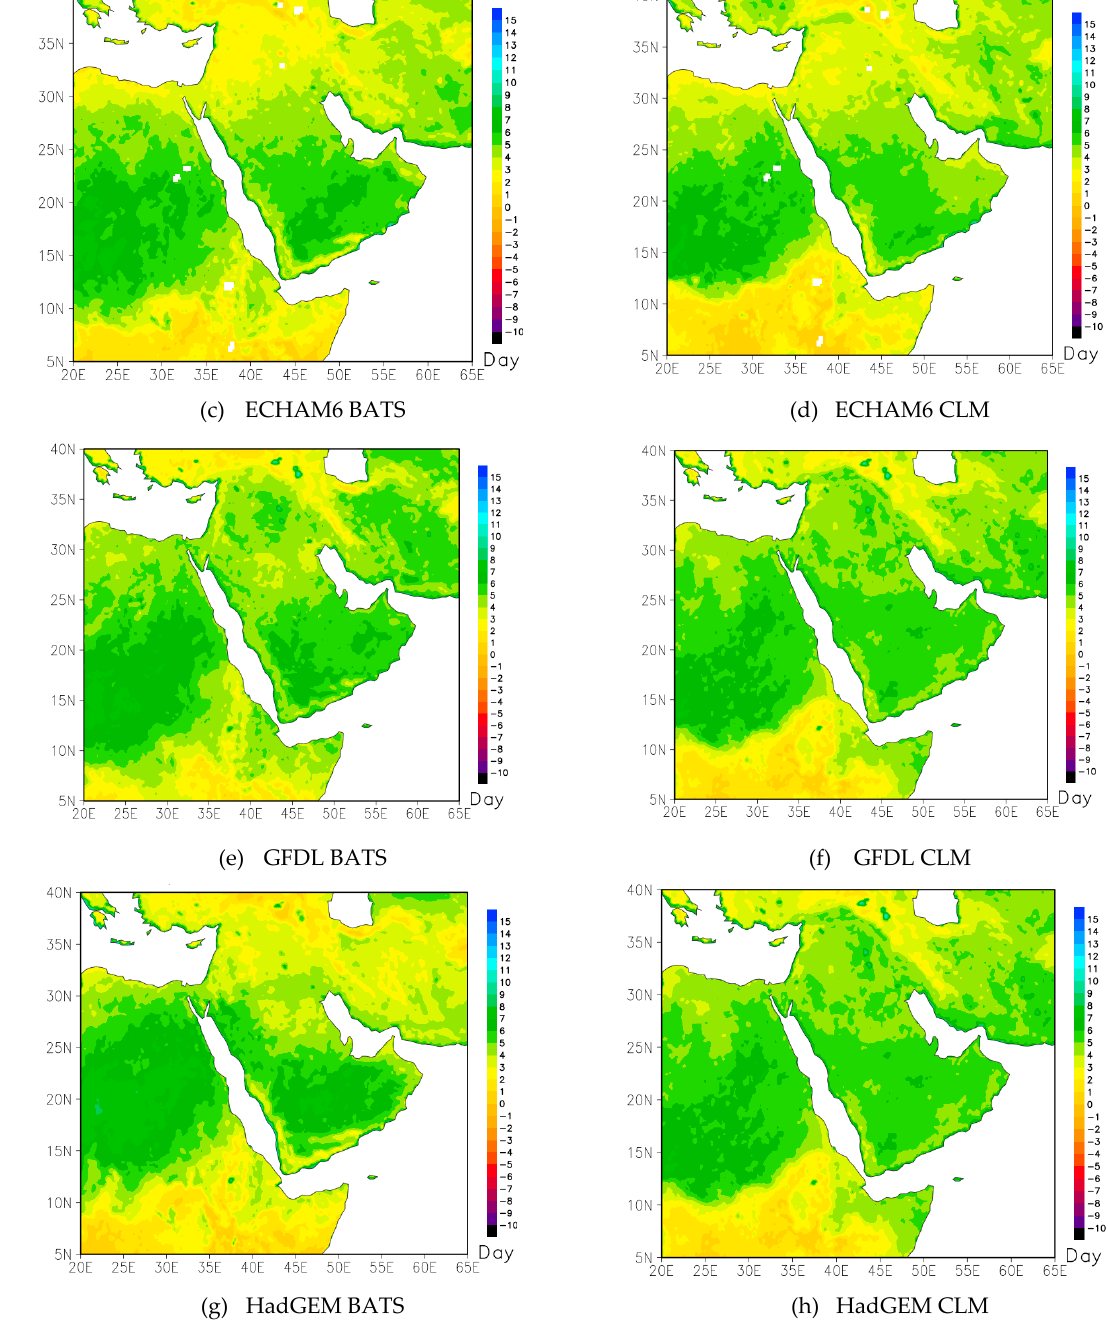
Figure 9. Spatial distribution of annual cold spell duration index (CSDI) for ( a ) ERA – Int BATS, ( b ) ERA – Int CLM, ( c ) ECHAM6 BATS, ( d ) ECHAM6 CLM, ( e ) GFDL BATS, ( f ) GFDL CLM, ( g ) HadGEM